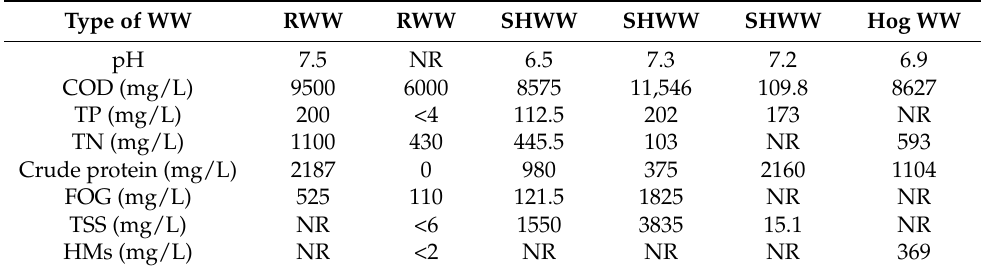
Table 1. Characterisation of various wastewater (WW) types associated with the meat-slaughtering process (rendering wastewater (RWW); not reported (NR); slaughterhouse wastewater (SHWW); chemical oxygen demand (COD); fats, oil and grease (FOG); total phosphorous (TP); total nitrogen (TN), total suspended solids (TSS), heavy metals (HMs))